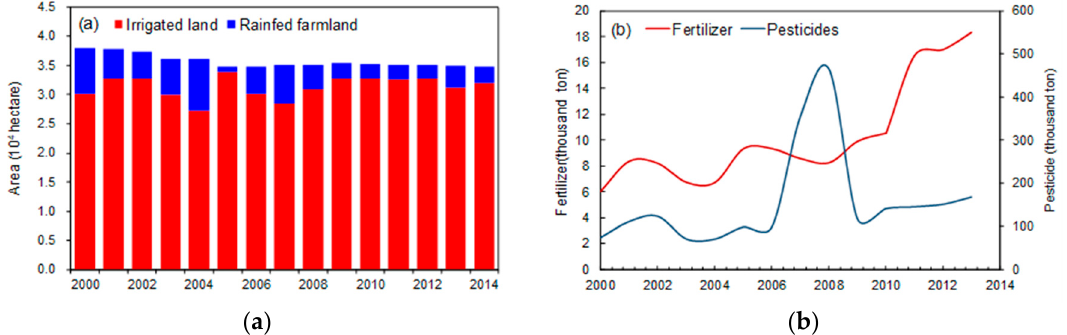
Figure 9. The variation trend in ( a ) irrigated land and ( b ) fertilizer and pesticides in Lhasa city from 2000 to 2014.